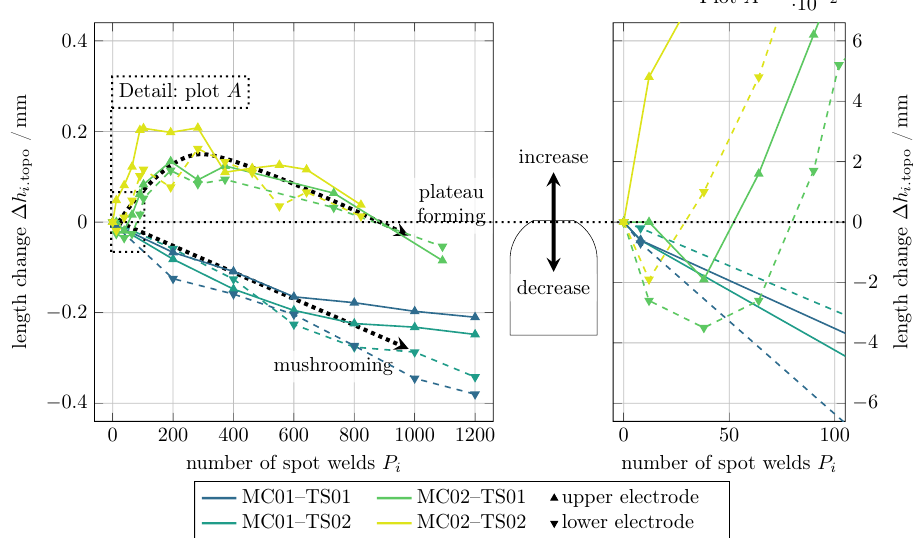
Figure 17. Different behavior in length change ∆ h i .topo of upper and lower electrodes from MC01 and MC02 as a result of two different wear modes, mushrooming and plateau